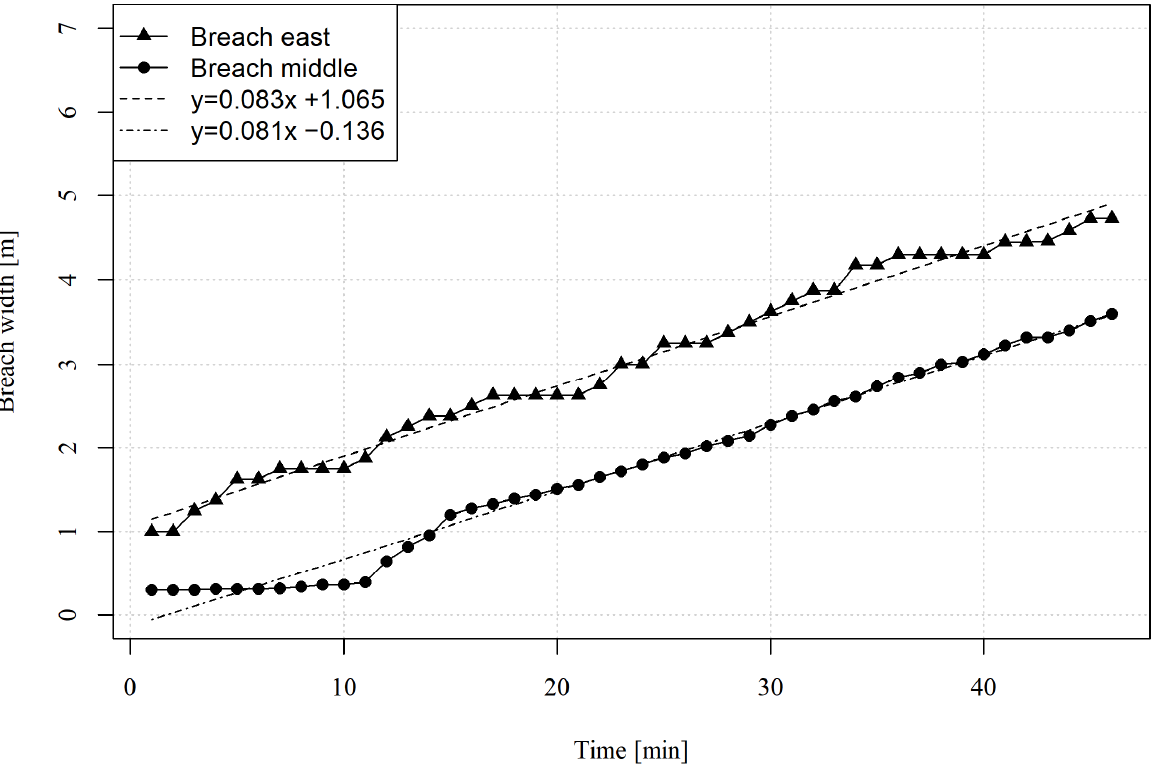
Figure 13. Linear development of the breach width. Initial width values of 0.30 m and 1.0 m due to missing laser-scanning data at the time of breach initiation.